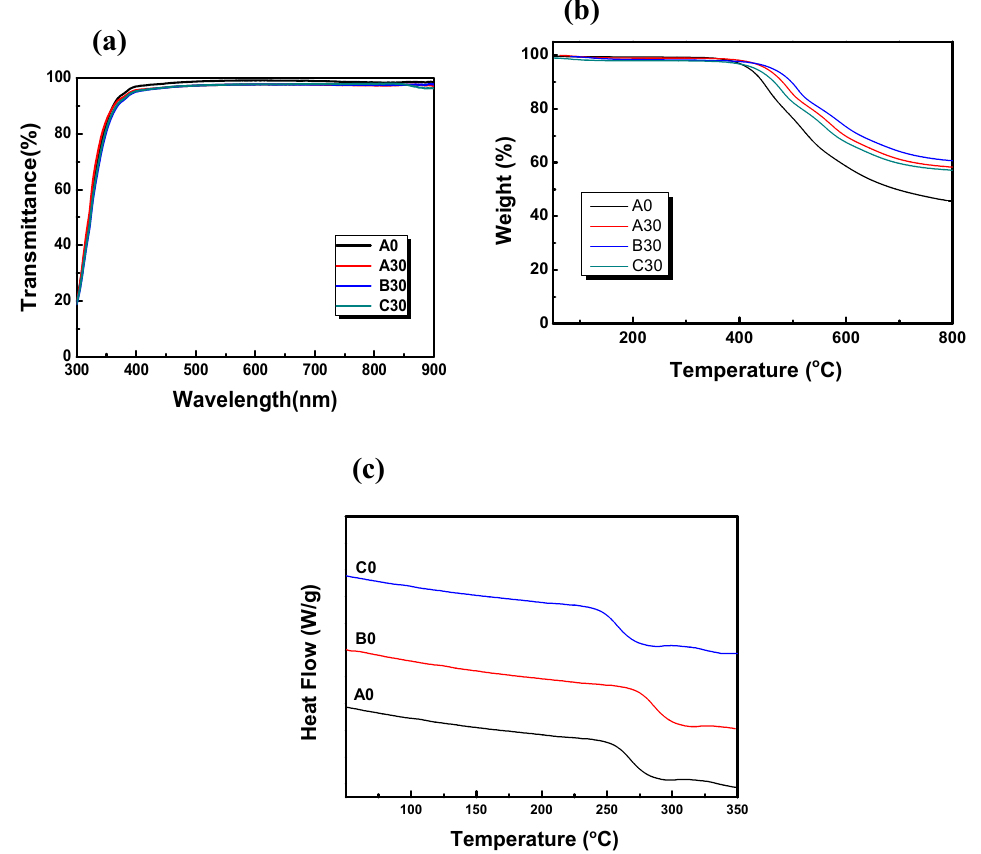
Figure 2. ( a ) UV-vis spectra of the optical transmittance, ( b )TGA curves, and ( c ) DSC curves of hybrid thin films.